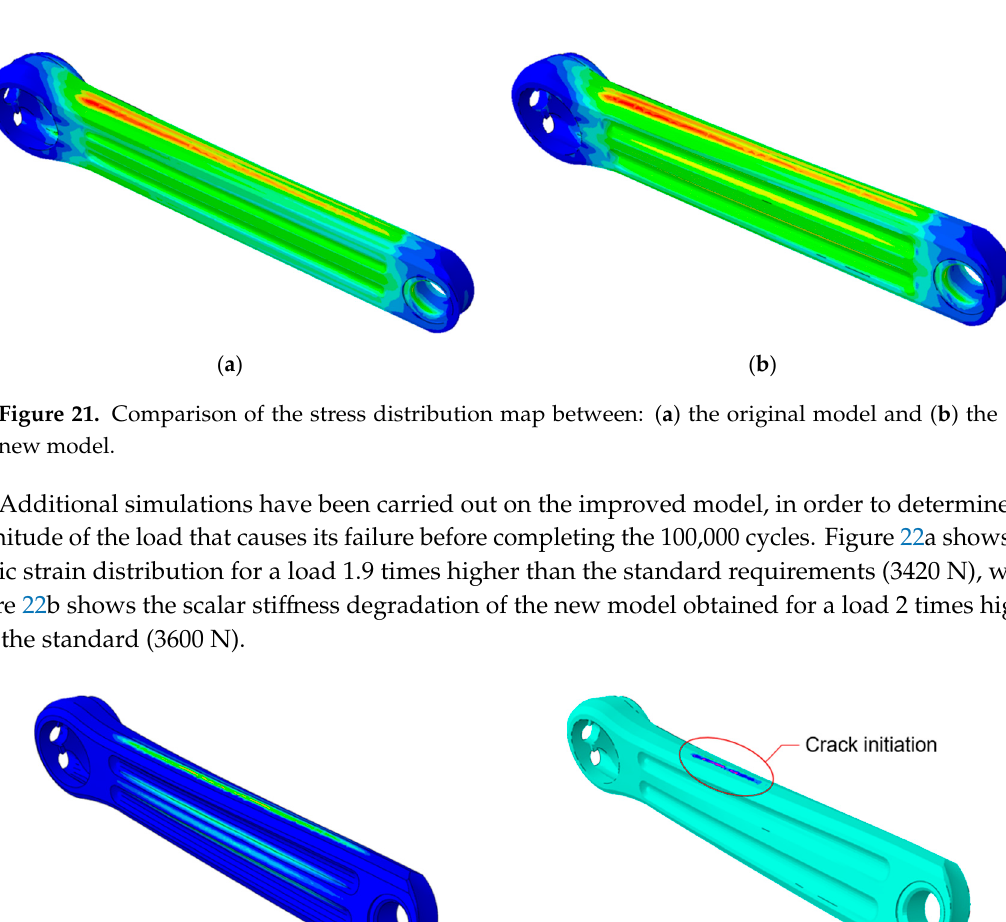
Figure 21. Comparison of the stress distribution map between: ( a ) the original model and ( b ) the new model.